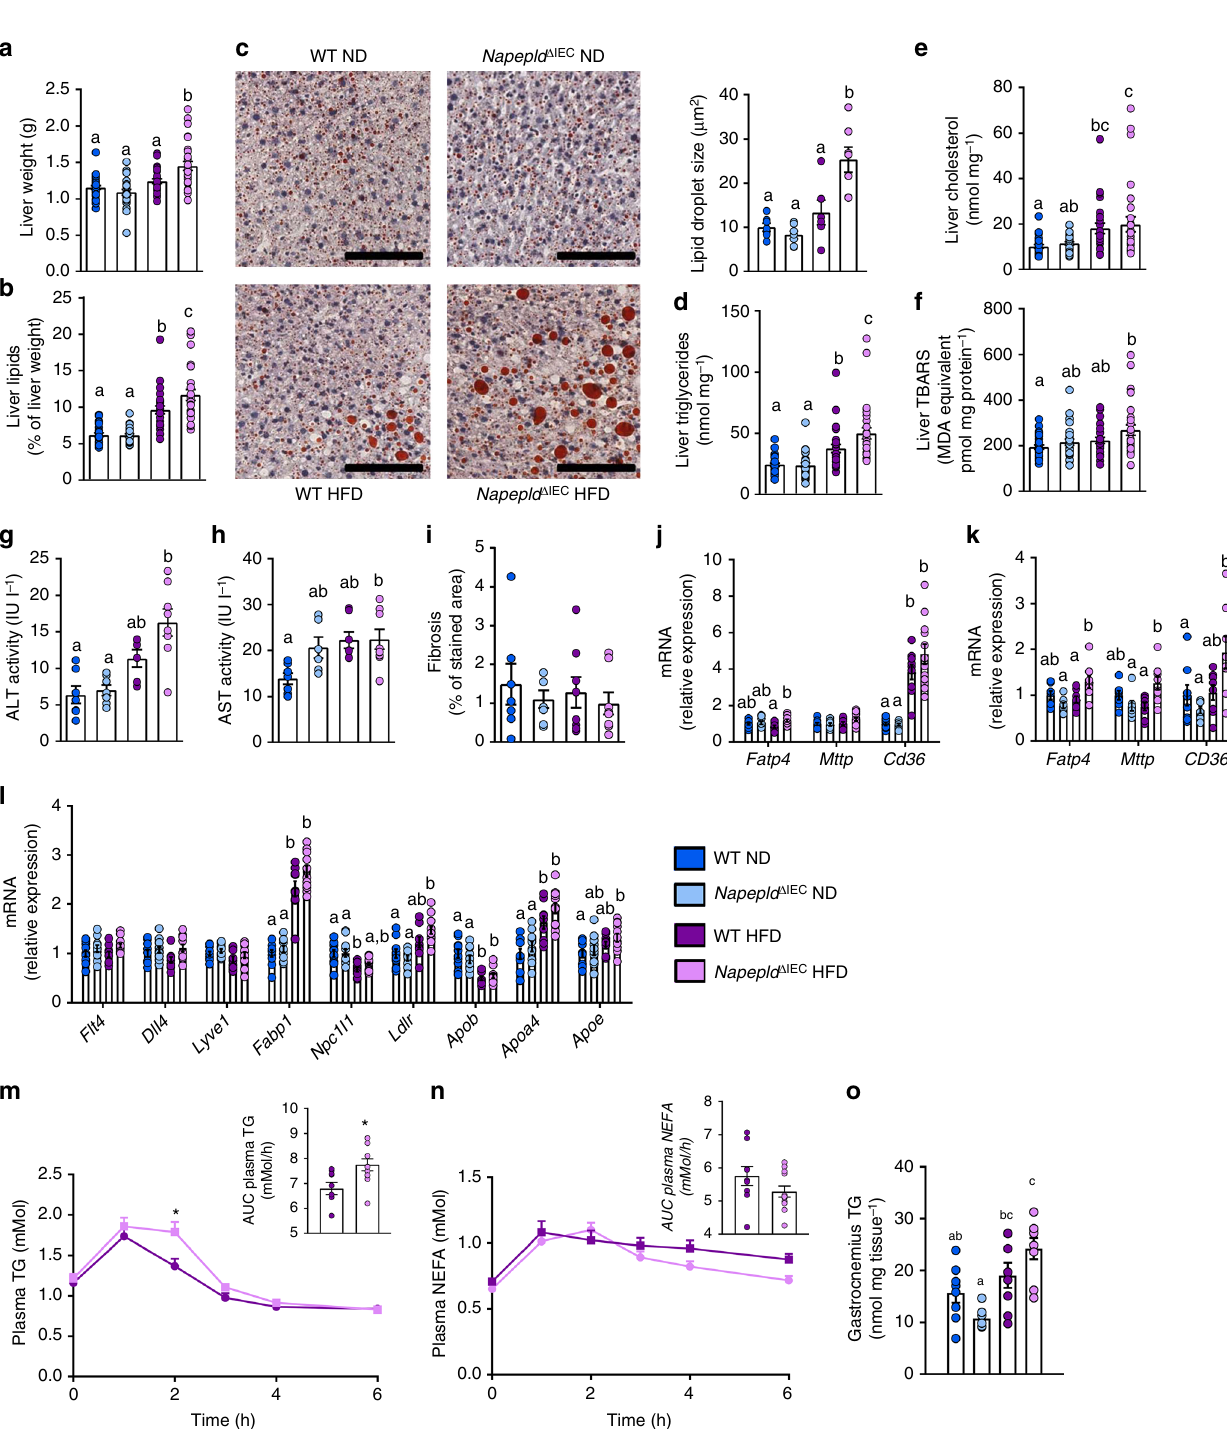
(Supplementary Figure 4C). Plasma triglycerides and non- esteri fi ed fatty acids (NEFA) were unchanged in all groups (Supplementary Figure 4D and E). Lipid peroxidation was sig- ni fi cantly increased in HFD-fed Napepld Δ IEC mice when com- pared to ND-fed animals (Fig. 6f). As compared to WT ND, plasma alanine aminotransferase tended to be increased in WT HFD mice and was signi fi cantly increased in HFD-fed